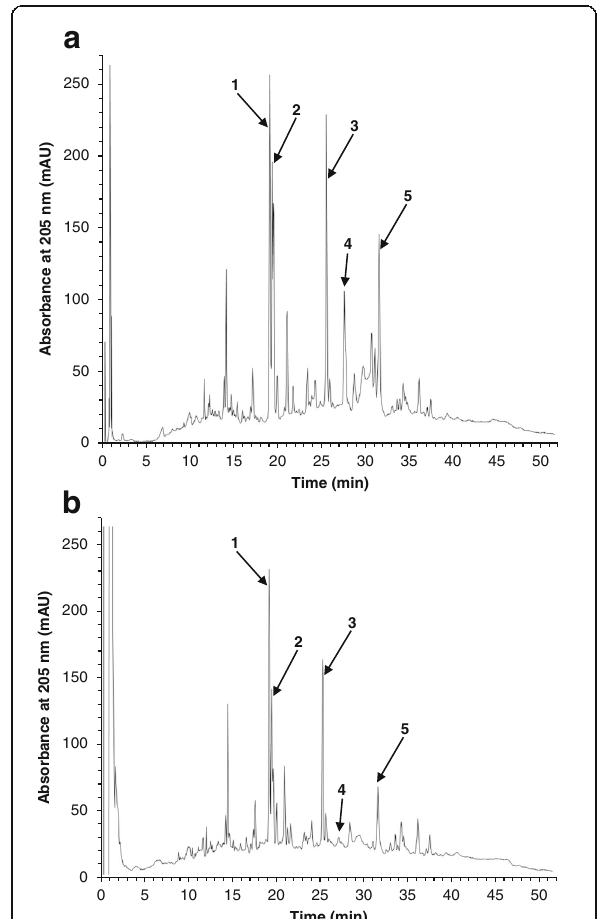
Fig. 2 Analytical reversed-phase HPLC traces of a methanolic extract of T. carbonaria cerumen (2 mg/mL), in the absence a and presence b of the free radical initiator, AAPH (80 mg/mL). Peak intensities that decreased in the presence of AAPH (numbered arrows) indicate constituent compounds that scavenged AAPH-derived free radicals after 8 h